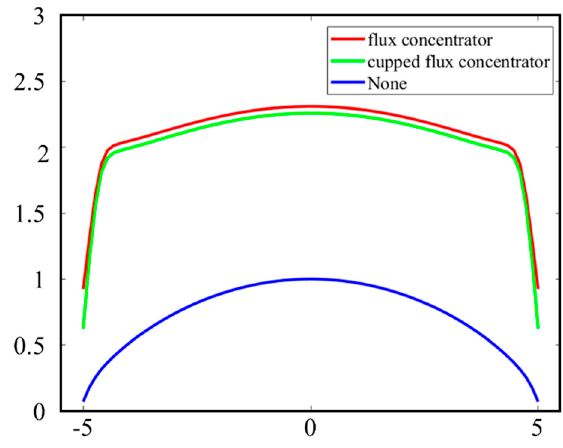
Figure 5. Transmittance of GAFDEM as a function of the weight of the search coil and the frequency of the search coil.